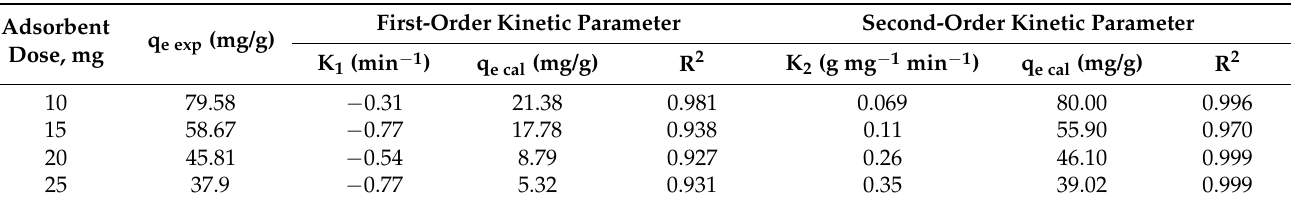
Table 1. The calculated parameters of the pseudo -first-order and pseudo -second-order kinetic model for various P@SiO 2 nano-composite.